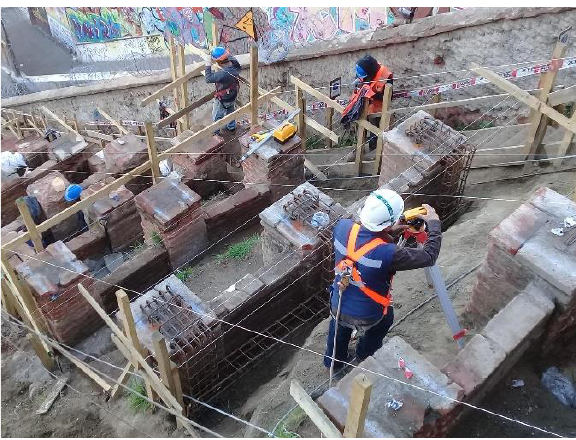
Figure 6. View of the masonry and its reinforcements.